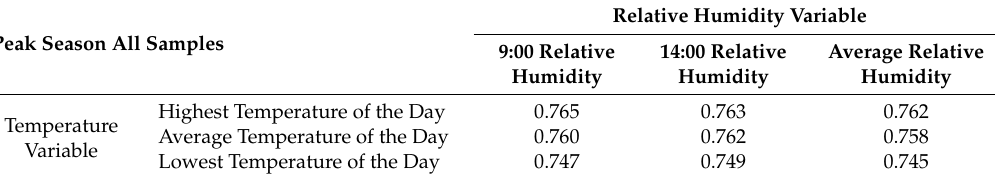
Peak Season All Samples